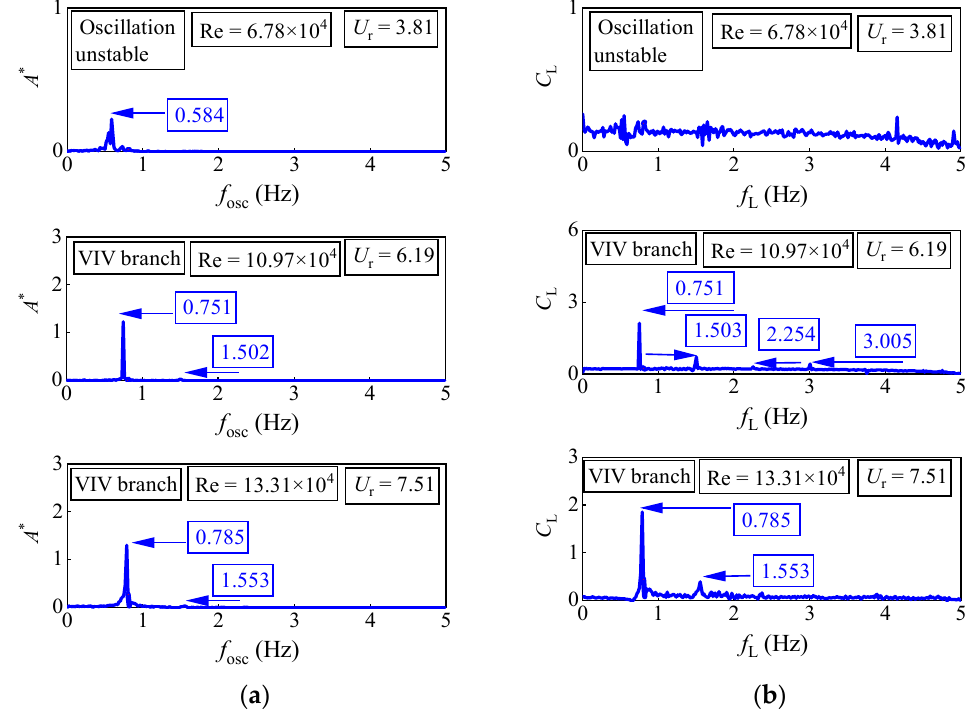
Figure 16. Spectral of Cir-T-Att with D = 0.14 m, R e = 6.75 × 10 4 ~1.61 × 10 5 . ( a ) Displacement spectral. ( b ) Fluid force spectral.